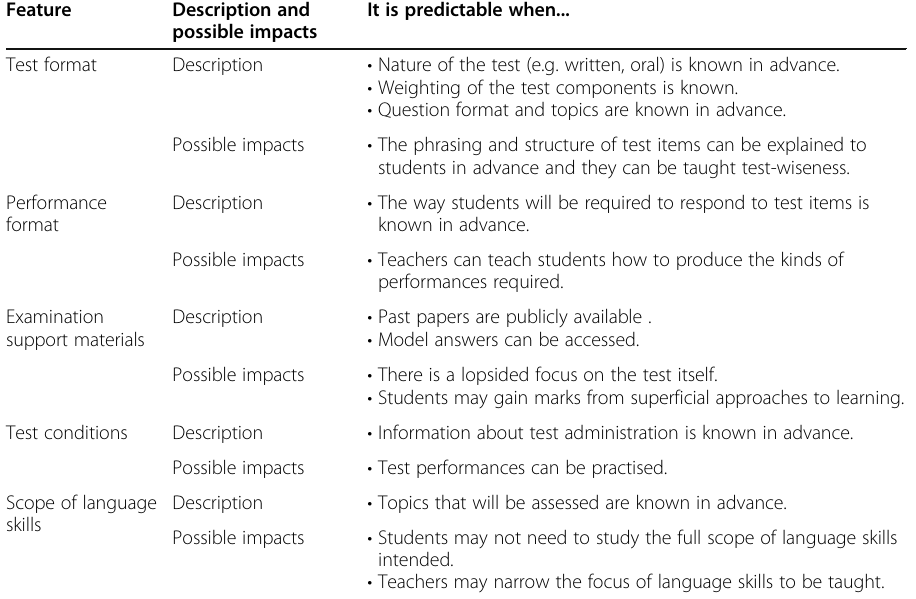
Table 1 Elements of test predictability based on Baird et al. (2014) Feature Description and It is predictable possible impacts